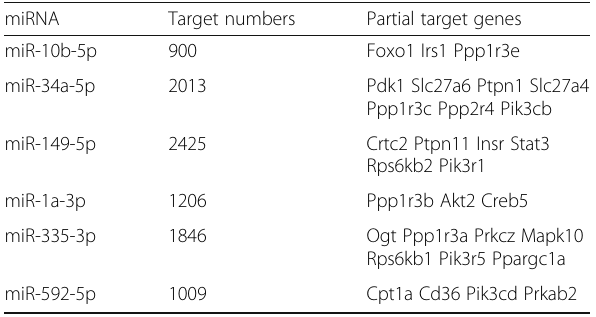
Table 2 Lists of 6 verified miRNAs and their targets with functions related to glucolipid metabolism or insulin resistance